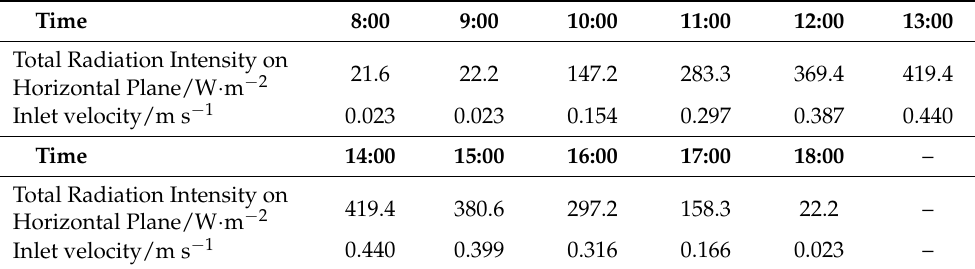
Table 2. Hourly solar radiation intensity and inlet velocity fitting